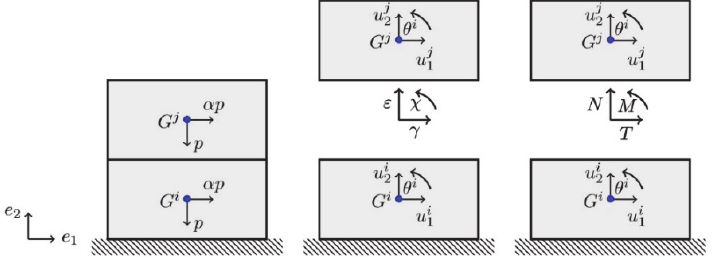
Figure 1: Simple two-block structure: dead and live loads, kinematic and static